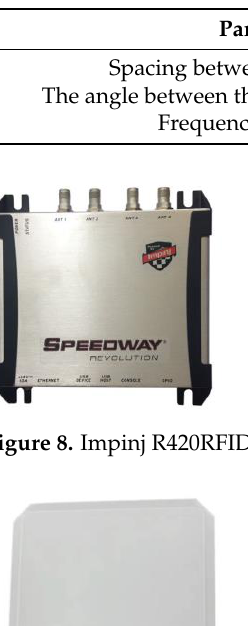
Table 1. Experimental parameters table.